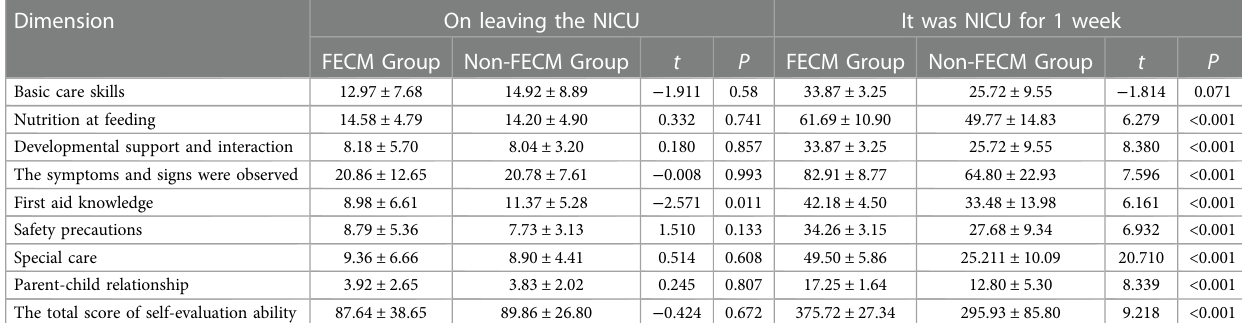
TABLE 4 The scores of the care ability questionnaire of the main caregivers of premature infants in the two groups at discharge and 1 week after discharge.